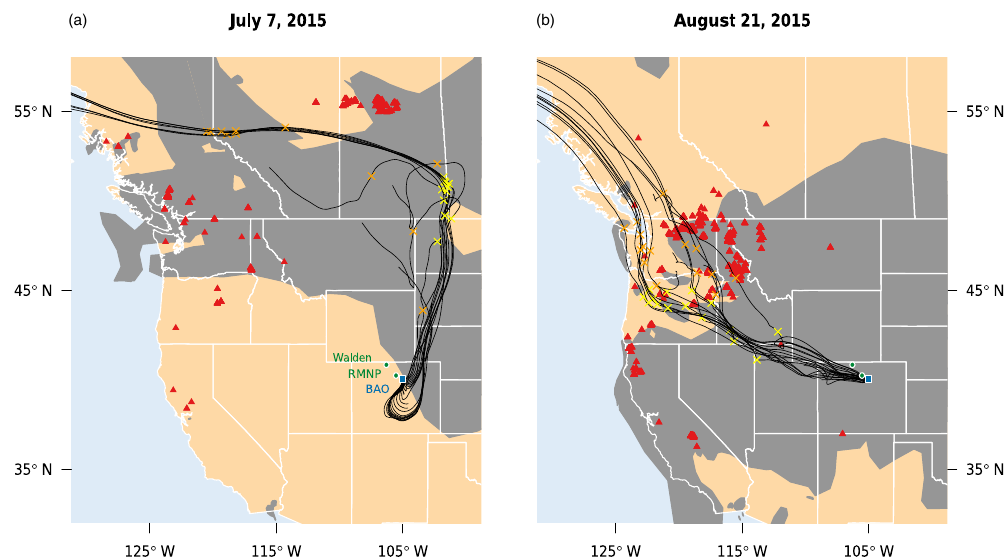
Figure 2. Representative days during each smoke period observed at the Boulder Atmospheric Observatory (BAO: blue square). NOAA Hazard Mapping System (http://www.ssd.noaa.gov/PS/FIRE/) smoke polygons are plotted in dark gray shading with MODIS fire locations (http://modis-fire.umd.edu/index.php) from the previous day plotted as red triangles. The thin black lines show HYSPLIT 120h back trajec- tories from the BAO site initiated at 1000ma.g.l. for each hour of the day plotted. Yellow cross-hatches display the location of each trajectory 48h back and orange cross-hatches indicate the 72h location. The green points show the location of the Rocky Mountain National Park and Walden measurement locations.